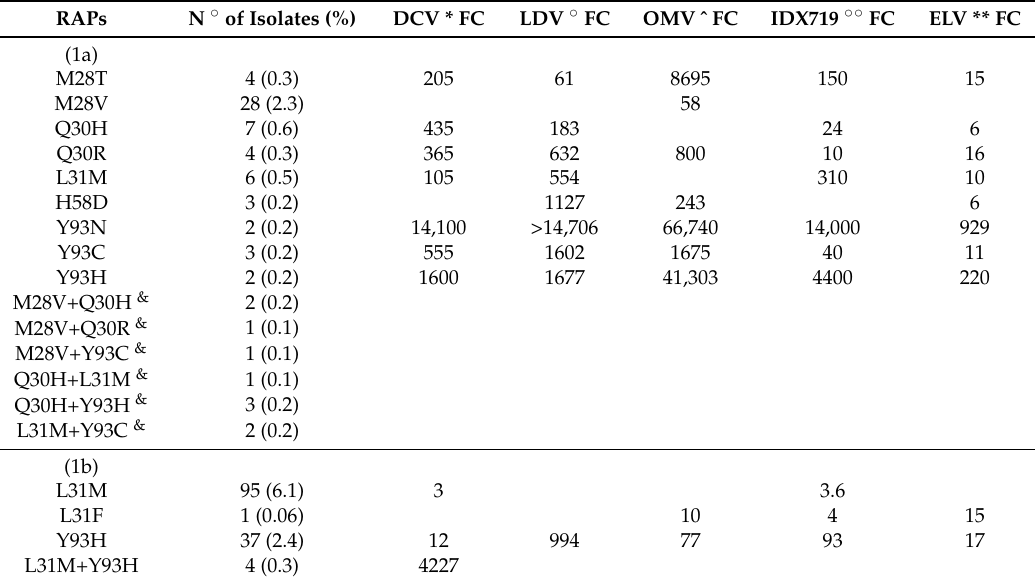
Table 1. Mean fold change in resistance compared to wild-type replicon of RAPs detected in G1a and G1b sequences retrieved from the Los Alamos HCV database and derived from NS5a inhibitors-naive